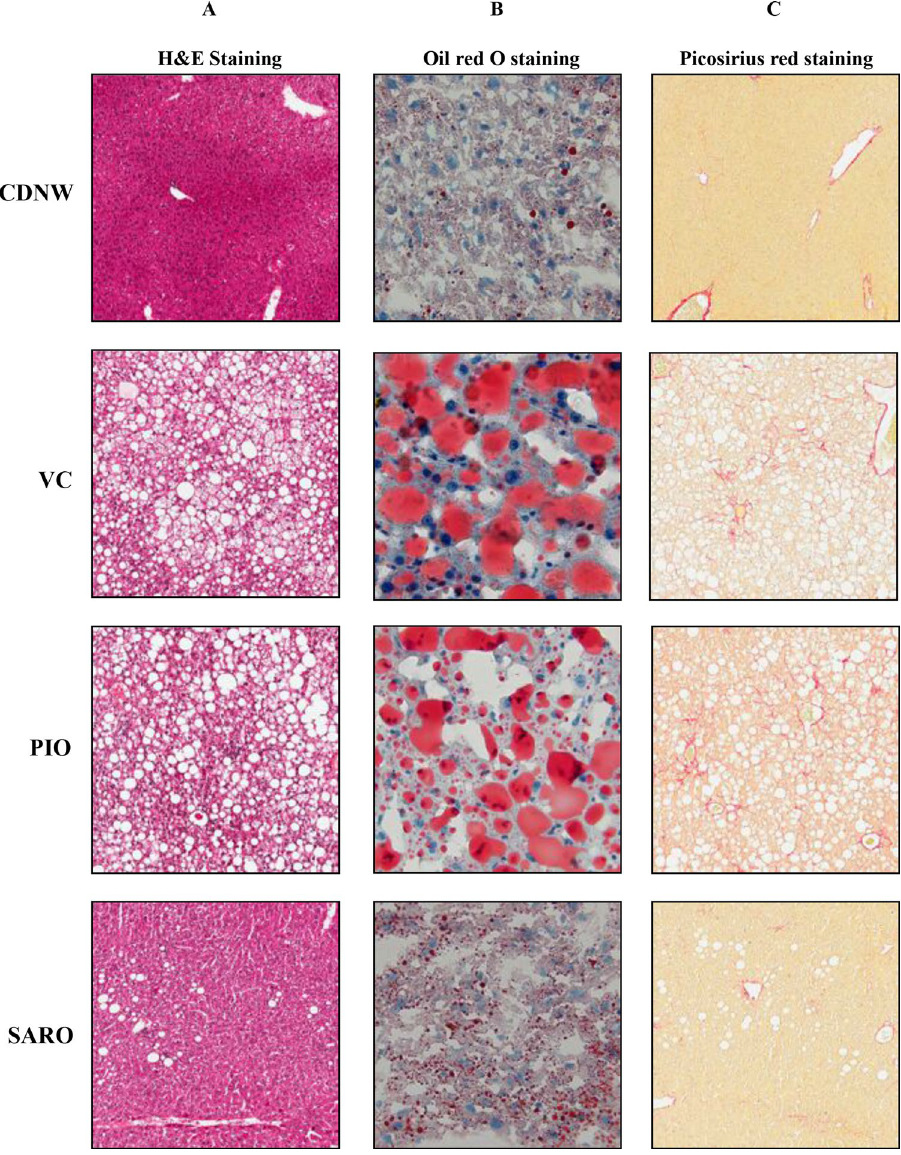
Figure 3. Saroglitazar treatment improved the liver histology of NASH in DIAMOND mice. DIAMOND mice were treated with pioglitazone, saroglitazar or vehicle control for 12 weeks along with CDNW or WDSW, which had developed fatty liver and steatohepatitis. Representative liver sections stained with Hematoxylin and Eosin (H&E), Picosirius red and Oil Red